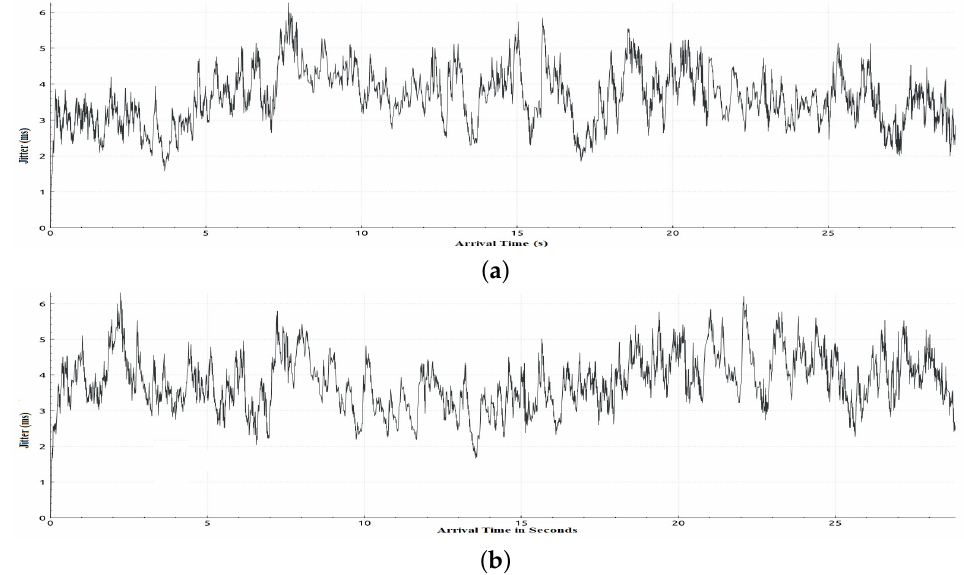
Figure 7. Jitter obtained in Scenario 1 in case of applying and without applying the proposed adaptive QoS model for 30-seconds video streaming traffic flow ( a ) Jitter obtained in Scenario 1 in case of applying the proposed adaptive QoS model, ( b ) Jitter obtained in Scenario 1 without applying the proposed adaptive QoS model.